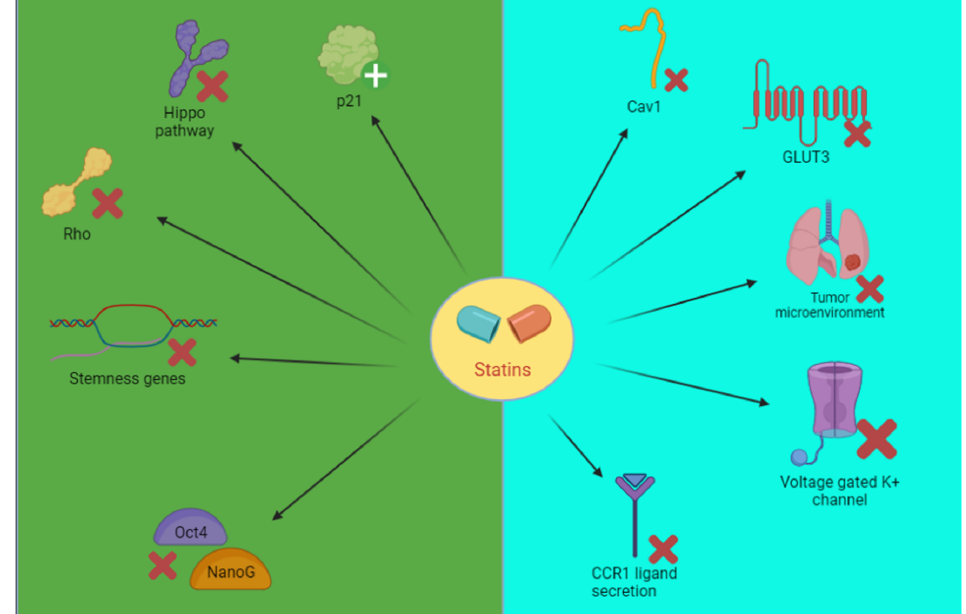
Figure 3. Schematic representation of the effects of statins on stem cells (green) or other possible mechanisms (light blue). Cav, caveolin; CCR, chemokine receptor type; GLUT, glucose transporter; Oct4, octamer-binding transcription factor 4; Rho, ras homologous protein. Other Targets